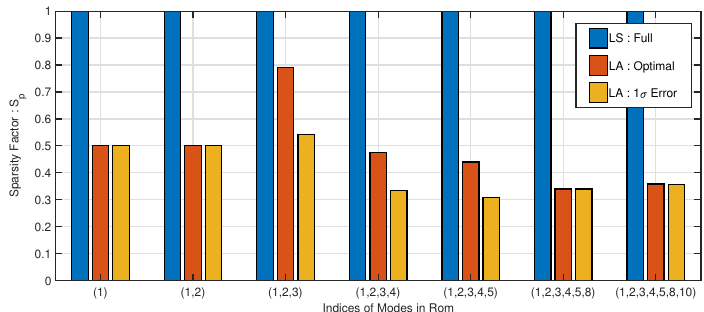
Figure 10. Bar plot depicting the sparsity factors for various orders of ROMs.